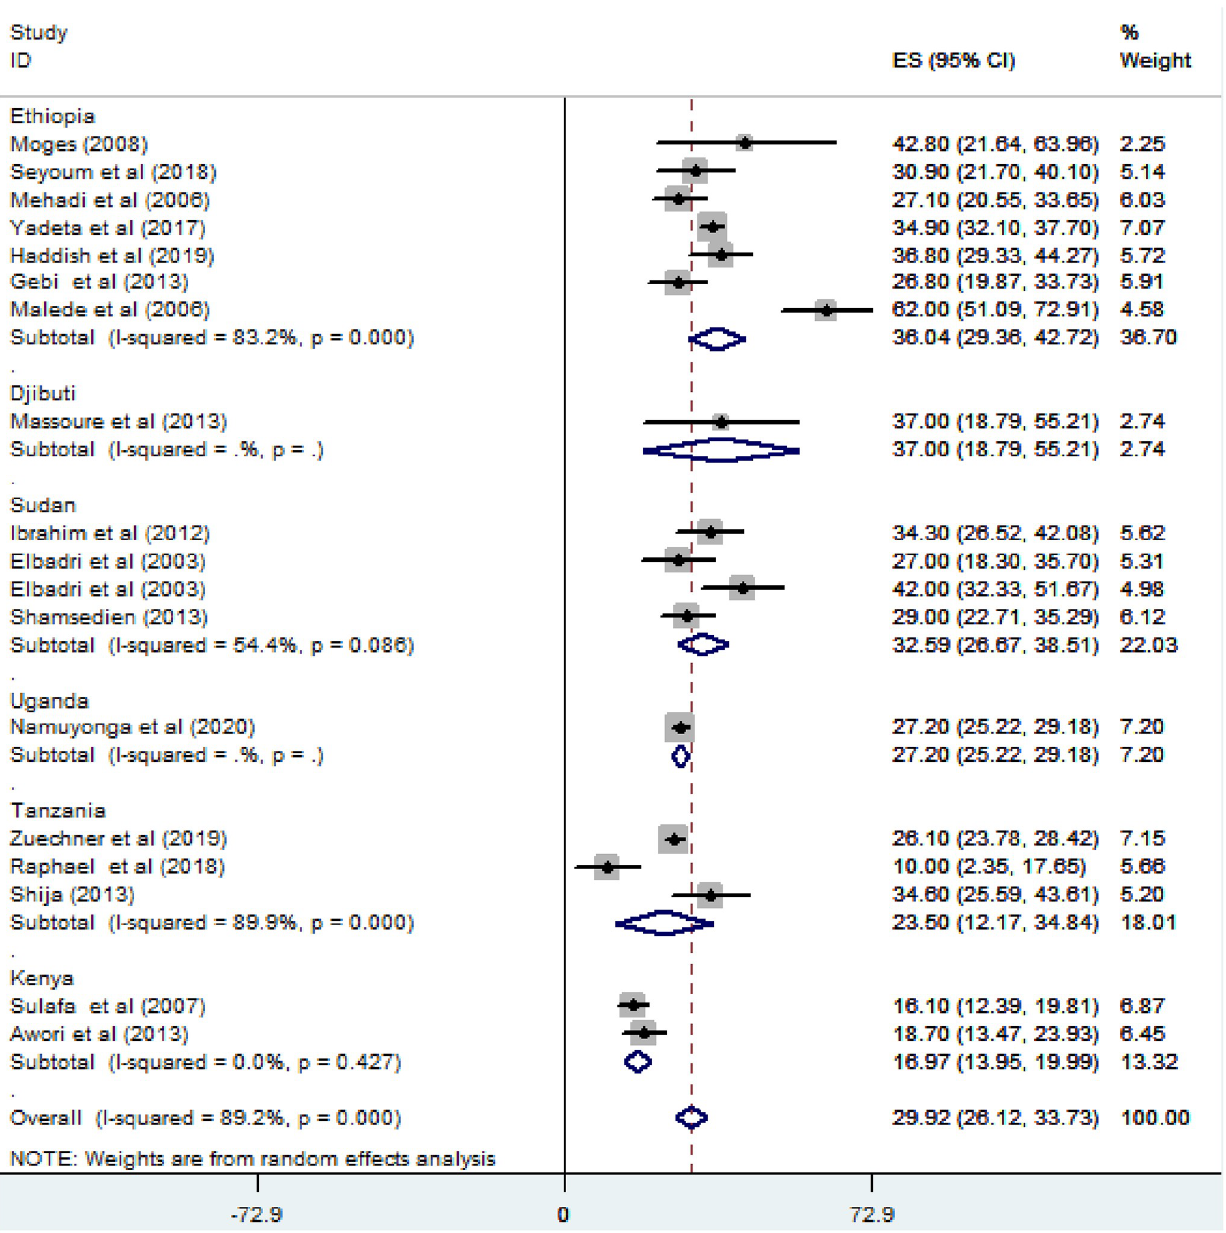
Fig 3. Forest plot showing the subgroup analysis of the pooled magnitude of ventricular septal defect among congenital heart defect patients based on the country in East Africa, from January 2000-October